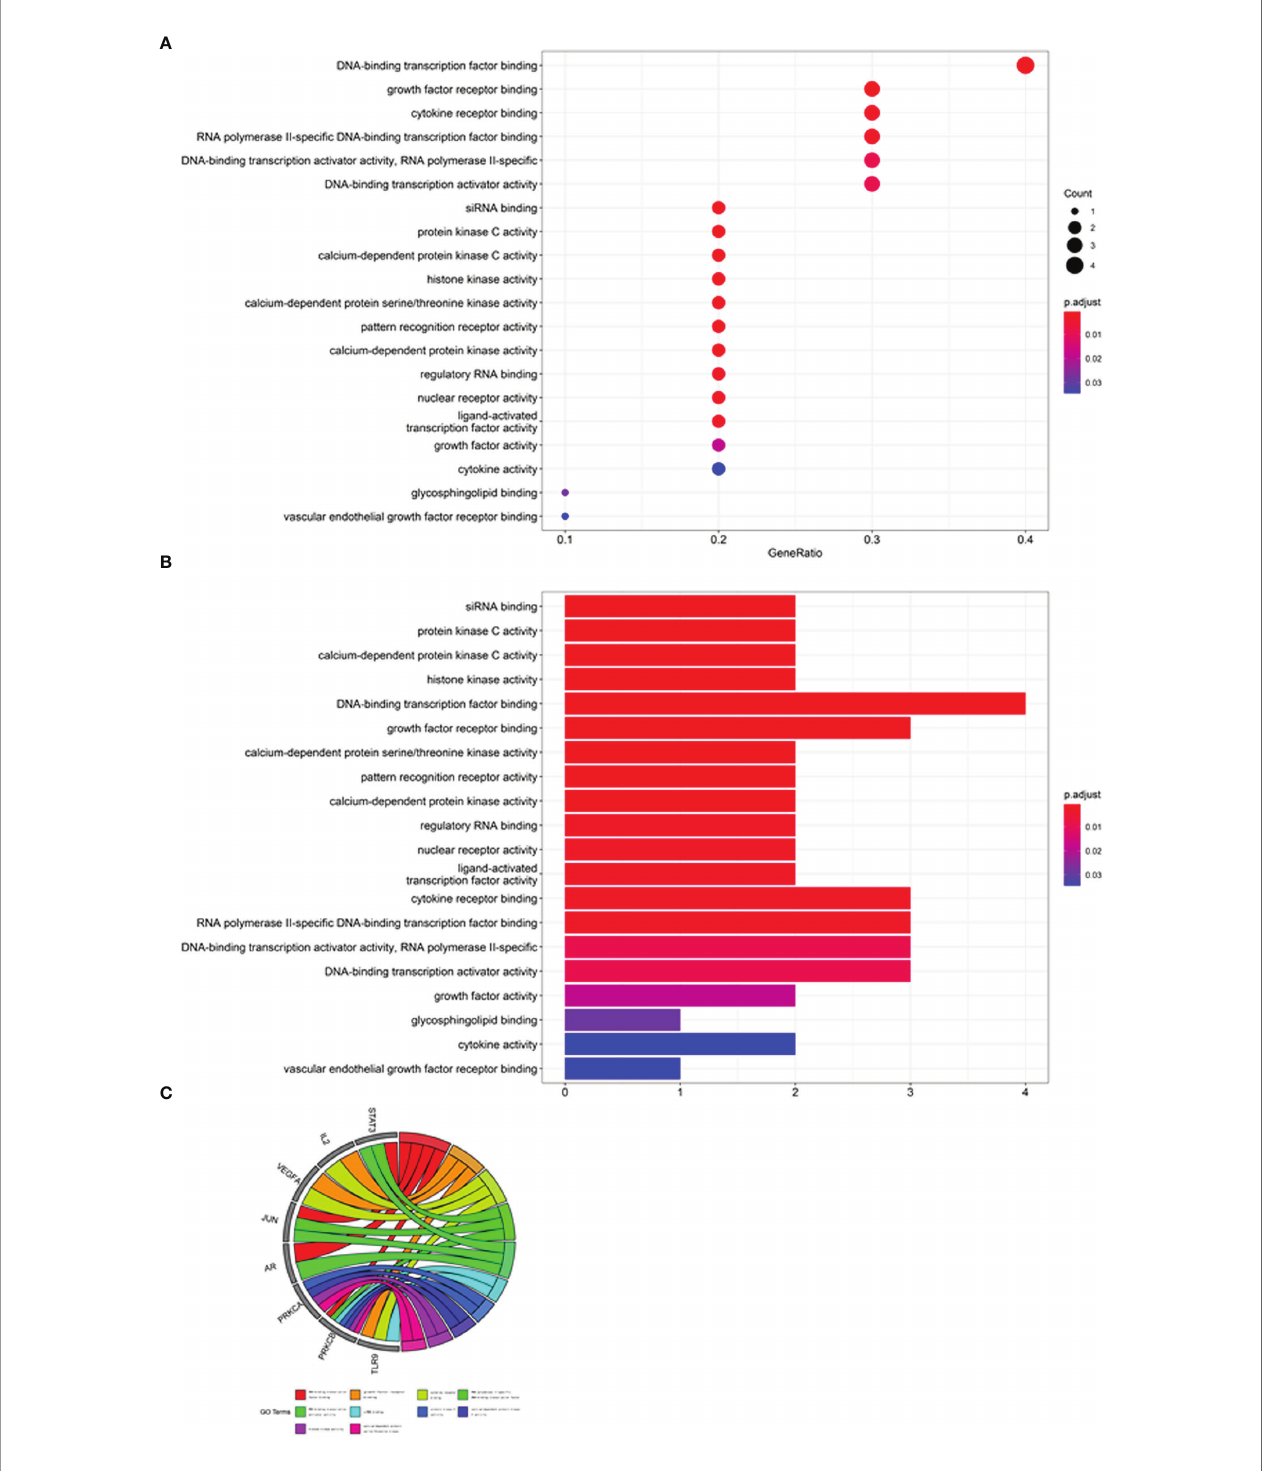
FIGURE 2 | GO enrichment analysis of core targets. Biological functions involved in GO characterised in bubble chart (A) , bar chart (B) , and circle diagram (C)